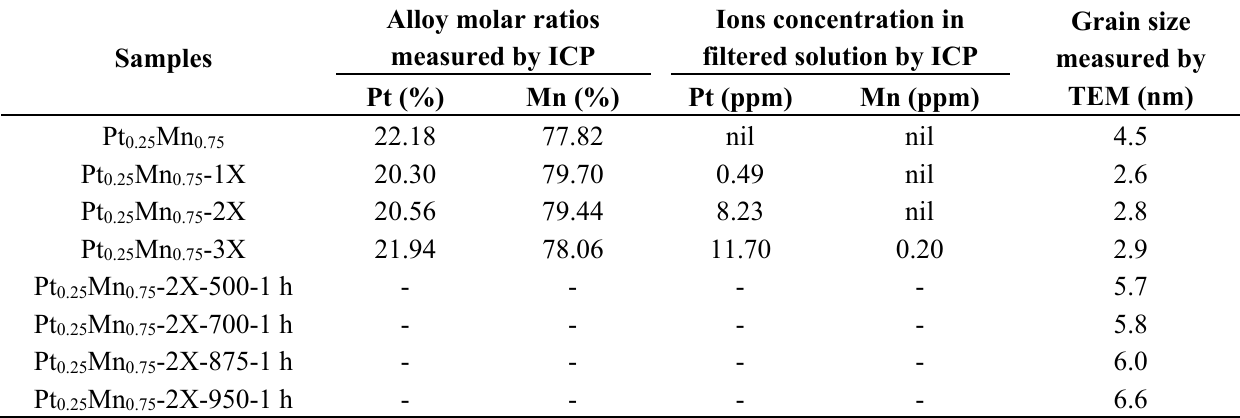
Table 1. Composition of the samples and concentration of Pt and Mn in filtrated solution, which was measured by ICP, along with grain size measured by